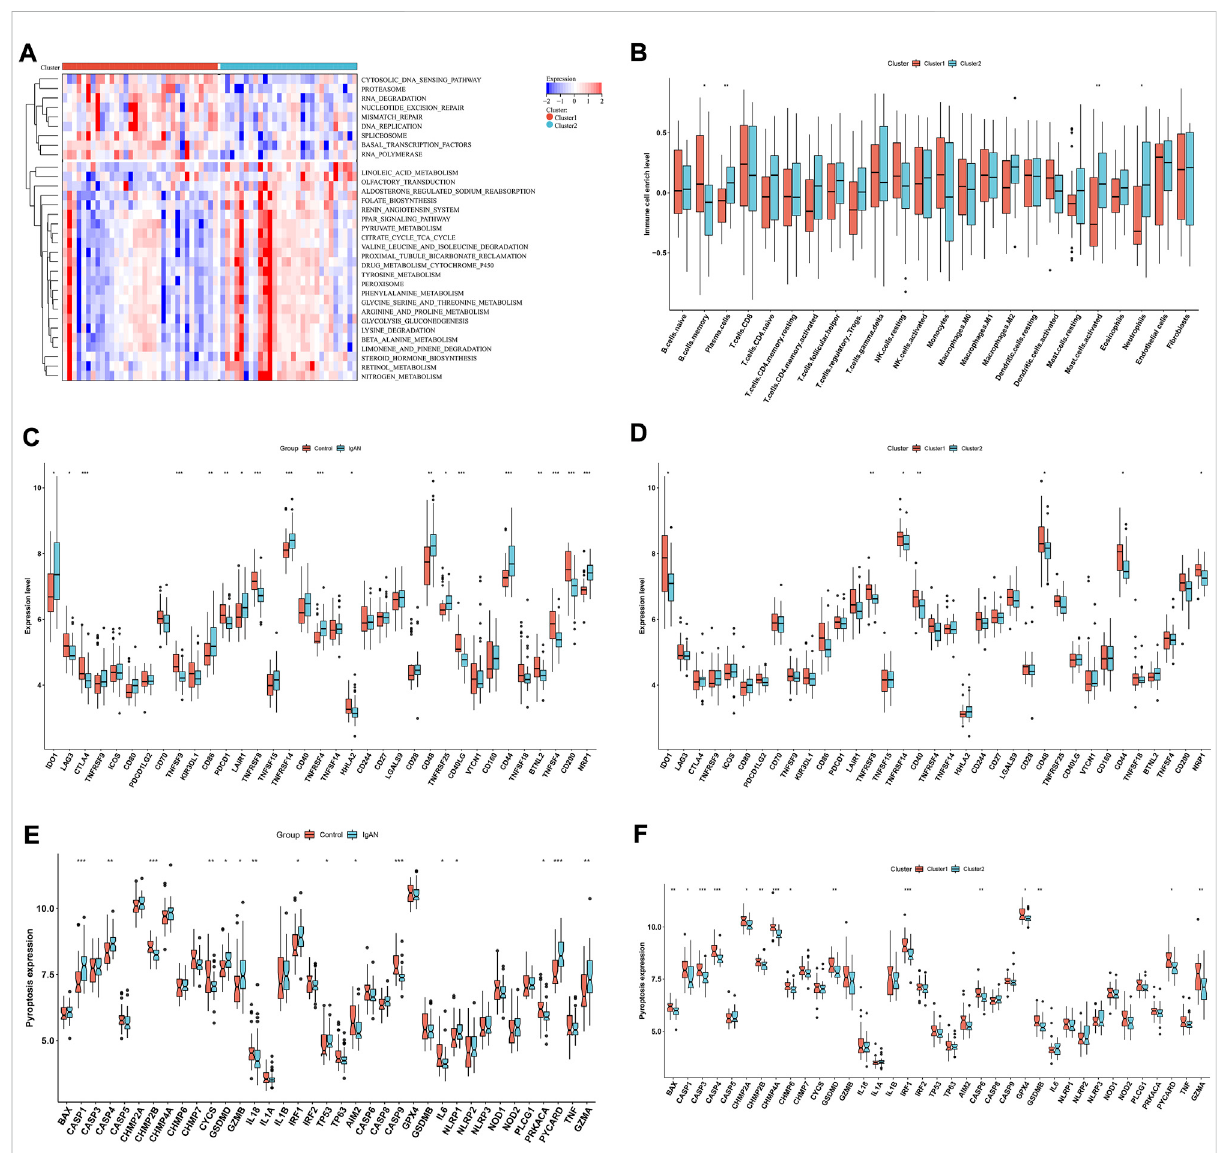
FIGURE 7 Differences in signaling pathways, immune cell in fi ltrations and immune checkpoints between hub RBPs-based subtypes. (A) Heatmap of the enrichmentlevelsofsignalingpathwaysbetweensubtypes. (B) Theenrichmentlevelsof24immunecelltypesbetweensubtypes. (C) Theexpression ofimmunecheckpointsinIgAnephropathyandnormalspecimens. (D) Theexpressionofimmunecheckpointsintwosubtypes. (E) Theexpressionof pyroptosis-relevant genes in IgA nephropathy and normal specimens. (F) The expression of pyroptosis-relevant genes in two subtypes. * p